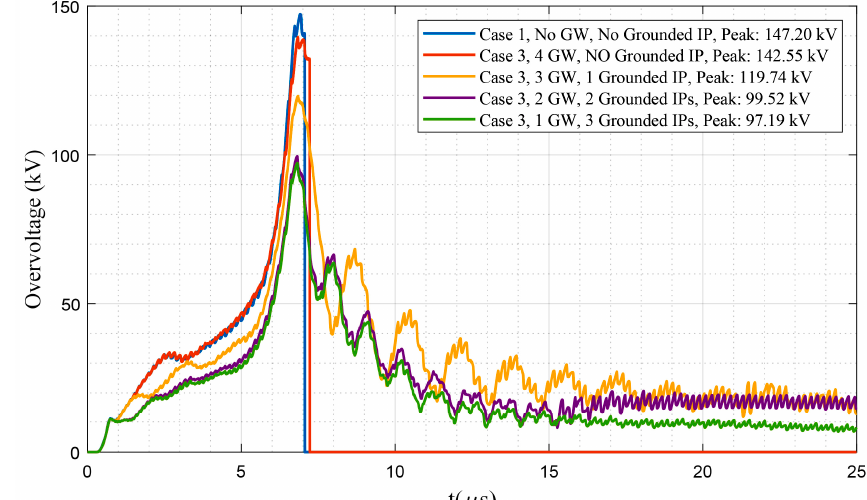
Figure 26. Comparison among the overvoltage stress at terminal c of the transformer mounted at pole #36 under di ff erent combinations of grounding and guy wire (GW) configurations of intermediate poles (IP); Network with dry poles under a lightning strike on pole #35.